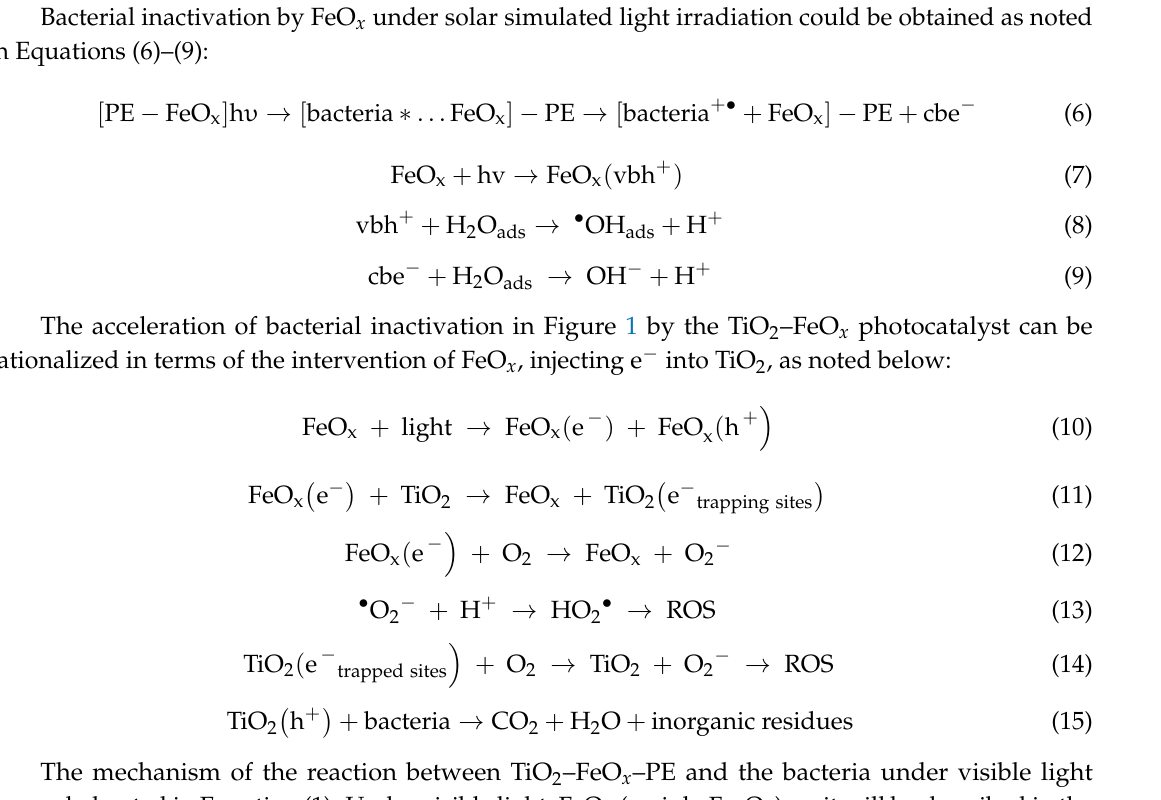
Figure 1. Escherichia coli inactivation (CFU/mL) on polyethylene (PE) films coated with (1) FeO x , (2) TiO 2 , and (3) FeO x –TiO 2 as a function of time of irradiation under low-intensity solar simulated light (50 mW cm − 2 ).